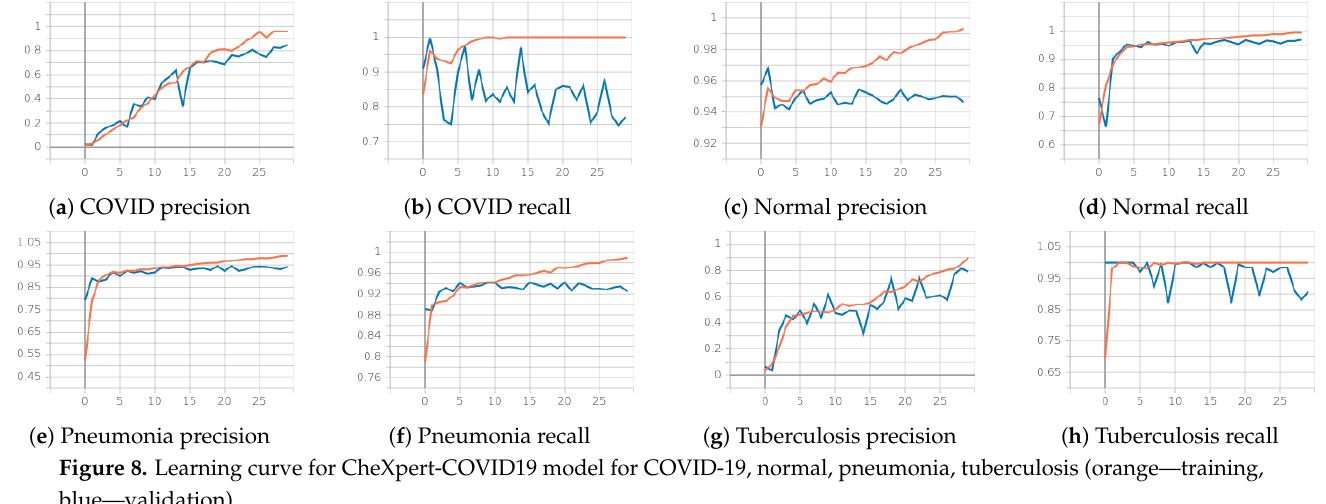
Figure 8. Learning curve for CheXpert-COVID19 model for COVID-19, normal, pneumonia, tuberculosis (orange—training, blue—validation).